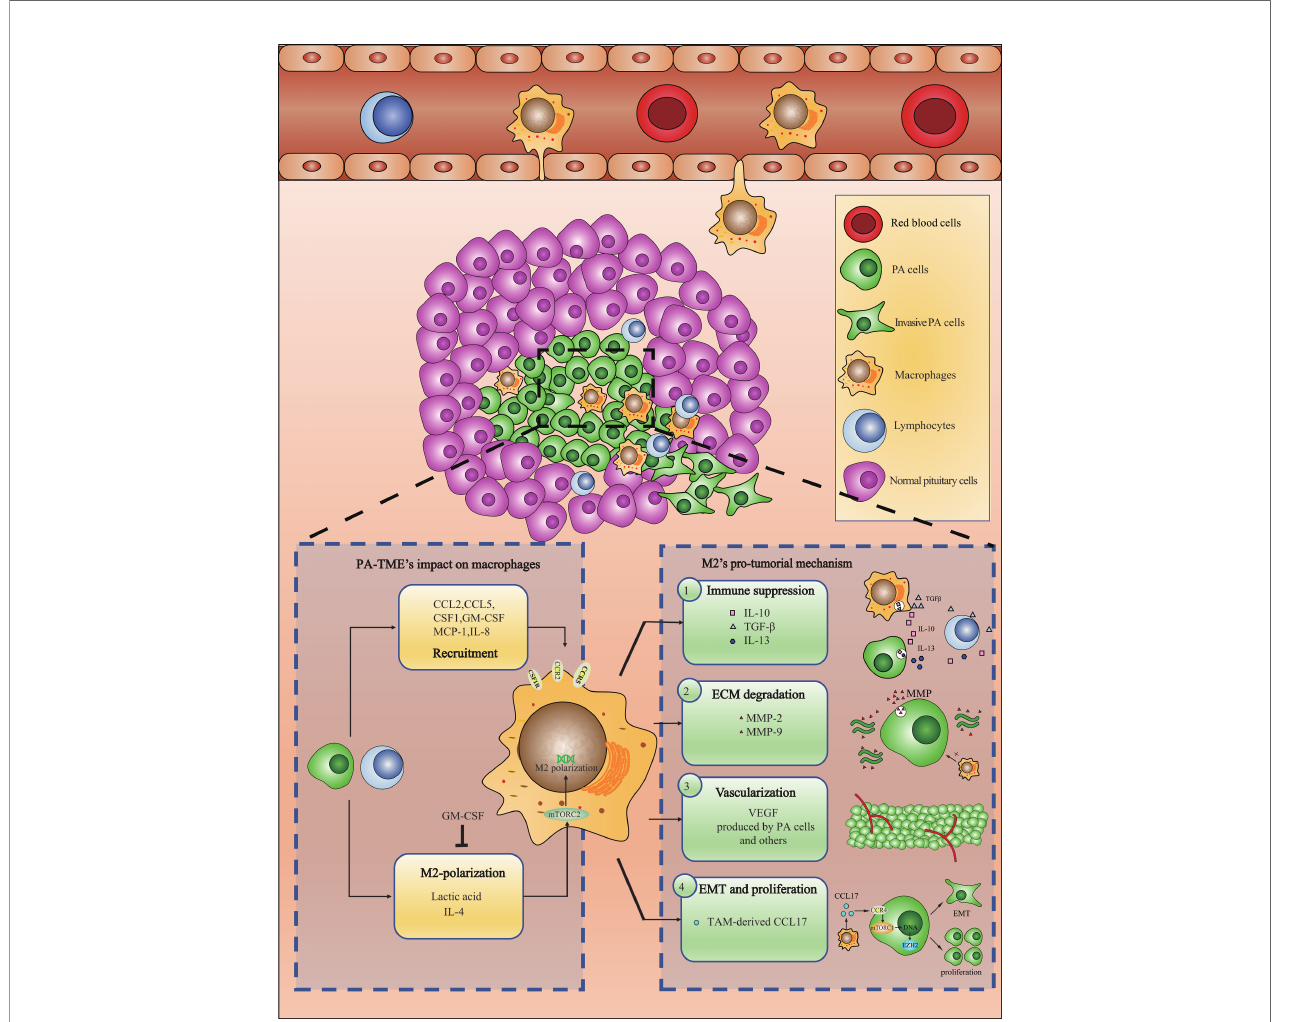
FIGURE 1 | Recruited macrophages polarize into M2-TAMs and promote PAs invasion through a variety of